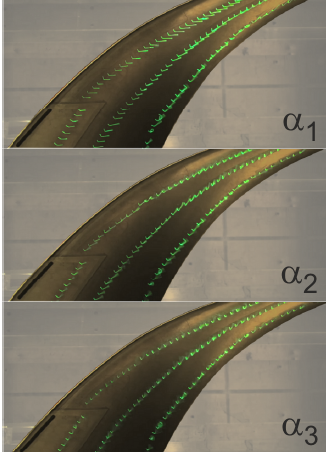
Figure 9. Progression of separation on the outboard section.